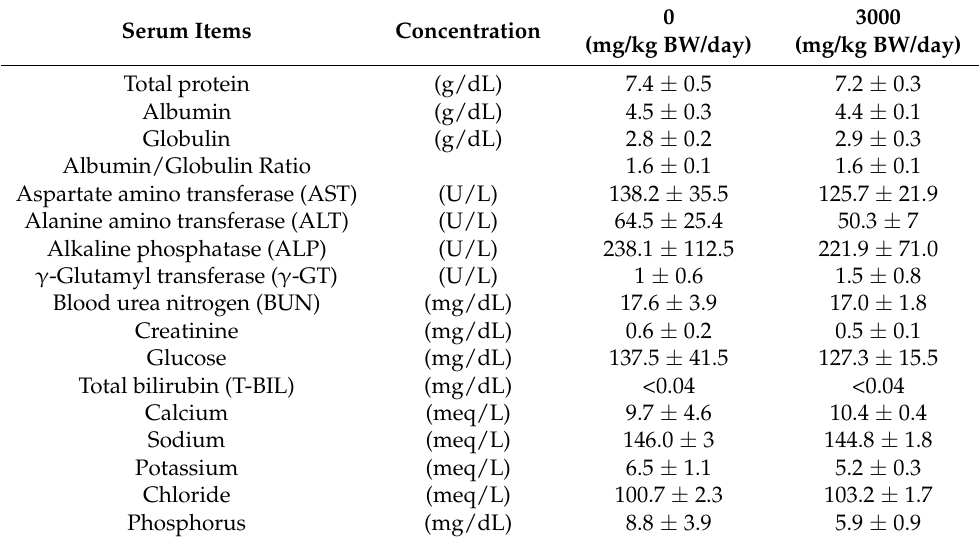
Table 4. Serum biochemistry findings in male Sprague–Dawley rats after 90 days of administration of 0 or 3000 mg/kg BW/day mycelial product obtained by white truffle solid-state fermentation. Serum Items